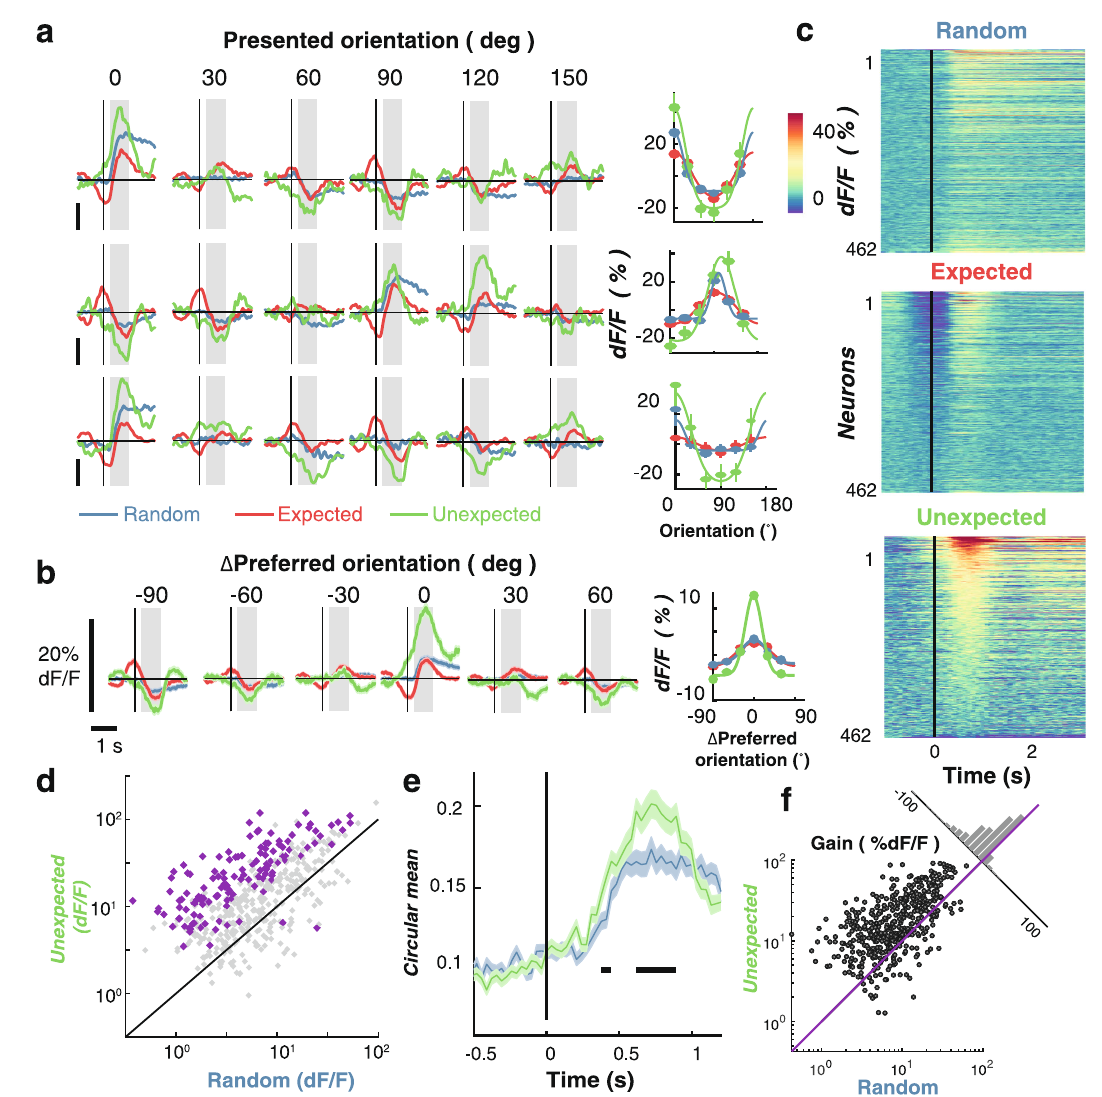
Fig. 2 | Expectation affects orientation-selective responses of individual V1 neurons.a Time-coursesofthreeexampleneuronsinresponsetoorientedgrating stimuli in the expected, Unexpected and Random conditions. Each neuron is illu- strated in a separate row, with the rightmost panel showing orientation tuning curves forthatneuron.The tuning is measured asthe averaged response from 250 to 1000ms after stimulus onset (grey shading).The solid curve is a fi tted Gaussian functionwithaconstantoffset. b SameasinA,butshowsactivityforallorientation- selective neurons ( N =462 neurons) aligned to their preferred orientation (0°) to allowaveraging.Rightpanel:SameasinAbutshowingtheGaussiantuningfunction for the population response. c Response to the preferred orientation across the three conditions for all orientation-selective neurons. For presentation the time- courses are smoothed with a Gaussian with a 33.3ms kernel. Every row represents the response of one neuron. In each panel, neurons are sorted based on their evoked response in the Unexpected condition (most excited on the top).